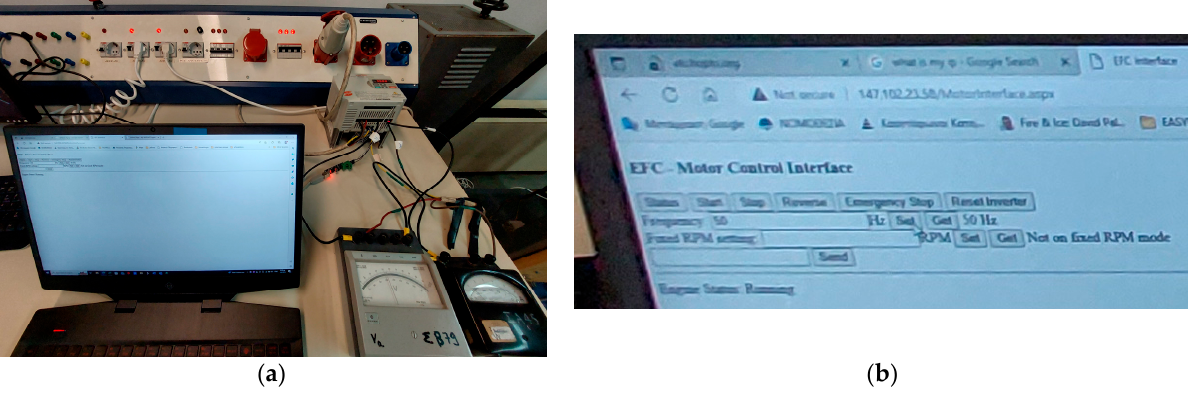
Figure 4. Experimental System (details): SBC, monitor, keyboard, mouse, inverter, adapter USB- RS485, voltmeter, central control panel.